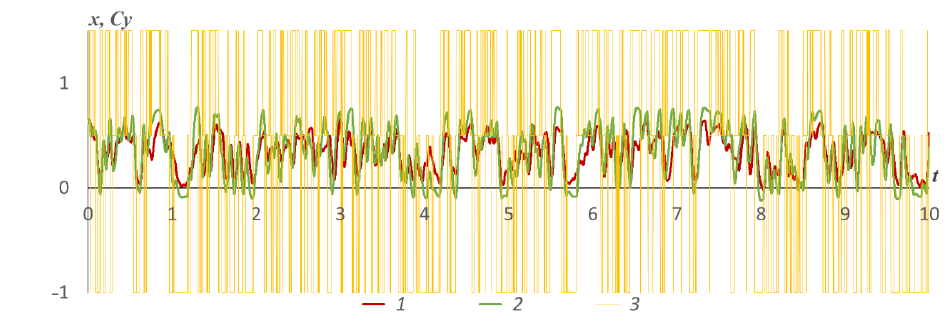
1 2 ; 2—system t i